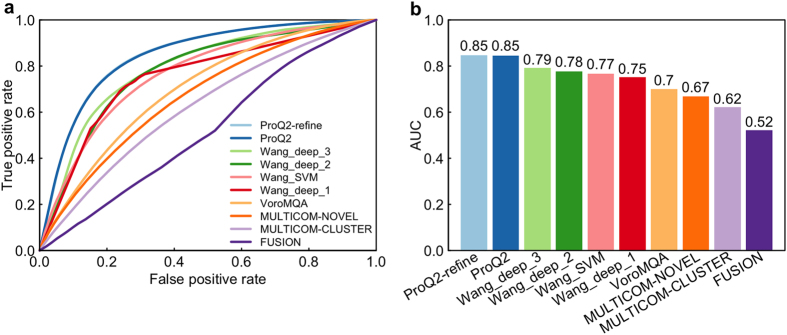
Local evaluation—the ROC analysis in stage_2 to assess the ability to identify reliable residues from unreliable residues.(a) The ROC curves for ten CASP11 QA tools and (b) the corresponding AUCs. Group names are sorted by their AUCs.